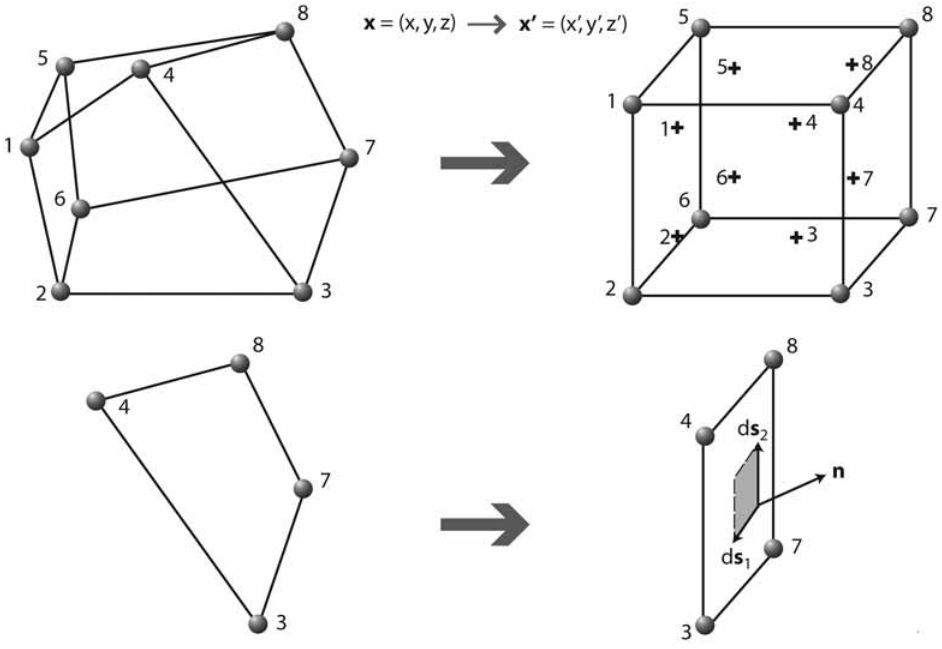
Fig. 4a,b. a) the Gauss integration is computed by mapping each arbitrarily distorted brick element ( x -space) to a trilinear hexahedral element ( x l -space). The two-points Gauss quadrature is performed by calculating the in- tegrand function at the 8 Gauss points indicated by «+» symbol. b) The surface integral within element faces is performed by mapping x into x l . The vectors d s 1 and d s 2 are defined to be tangent to the surface, defining the unit area shaded (see text for